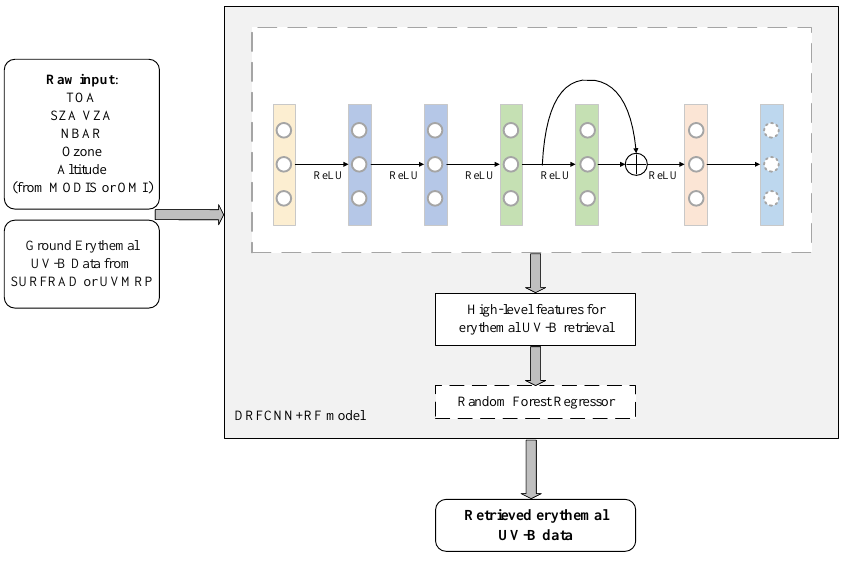
Figure 2. The structure of the proposed deep learning (DL)-based erythemal ultraviolet-B (UV-B) retrieval